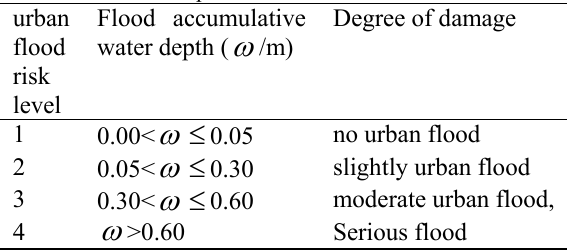
Table 4. Water depth classification of flood areas.